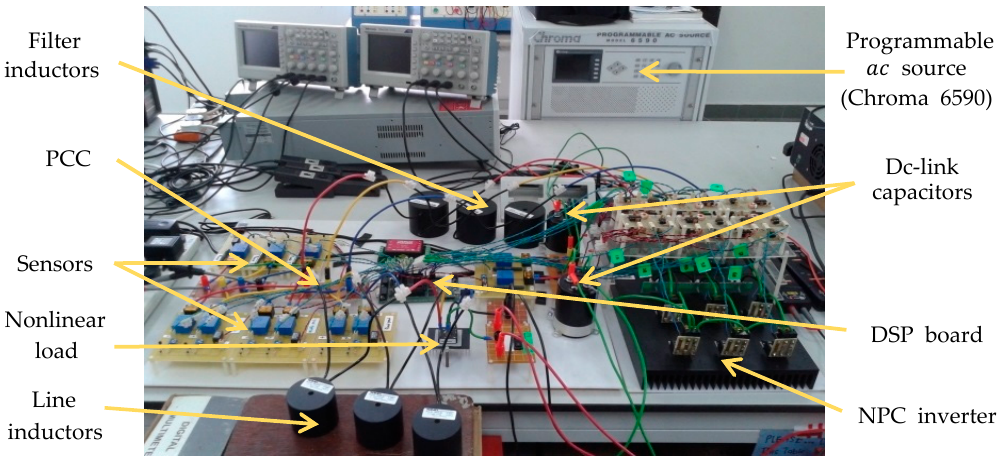
Figure 9. Laboratory prototype developed to validate design concept and performance of the proposed dual-function pq theory algorithm.